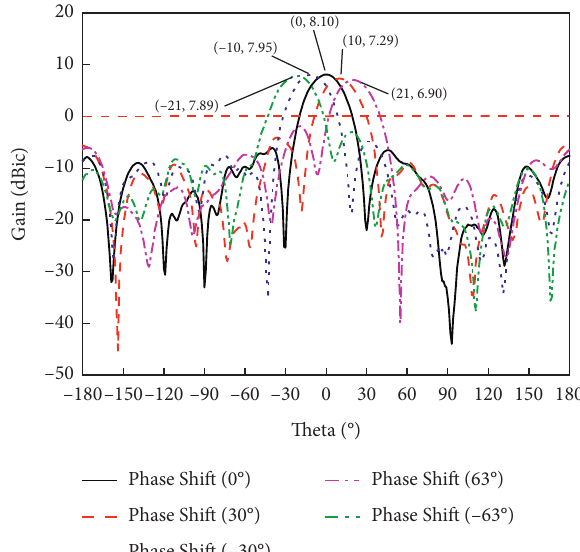
Figure 13: Measured normalized radiation patterns of the pattern reconfigurable antenna array at 2.6 GHz on the yoz -plane.